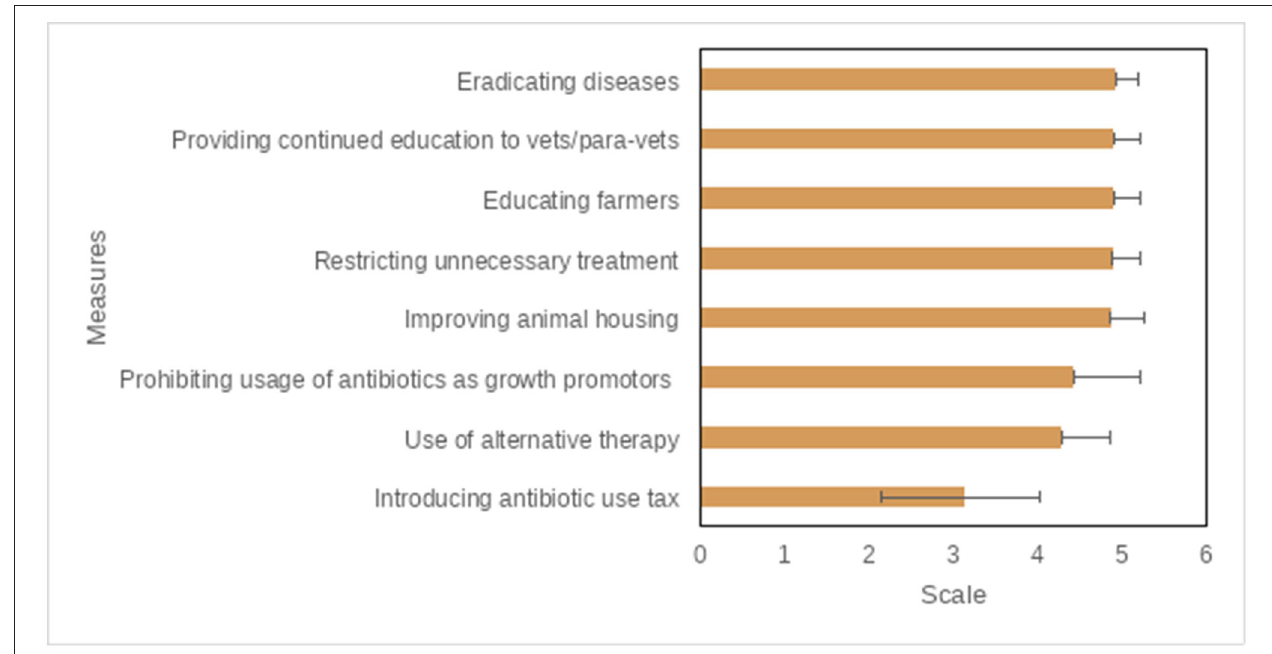
FIGURE 7 | Potential measures to control the excess use of antibiotics/antimicrobials, questions were scored on a 5-point Likert scale (1 = Not important; 2 = Slightly important; 3 = Fairly important; 4 = Important; 5 = Very important), the mean score is displayed here from lowest to highest.